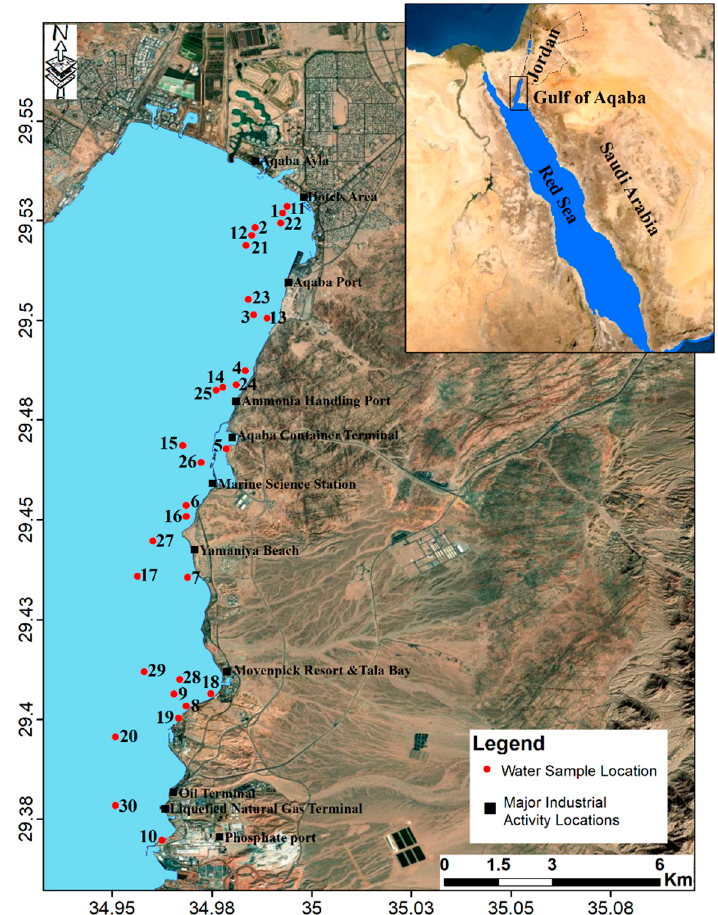
Figure 1. Location map of the Gulf of Aqaba (GoA) and sampling sites.